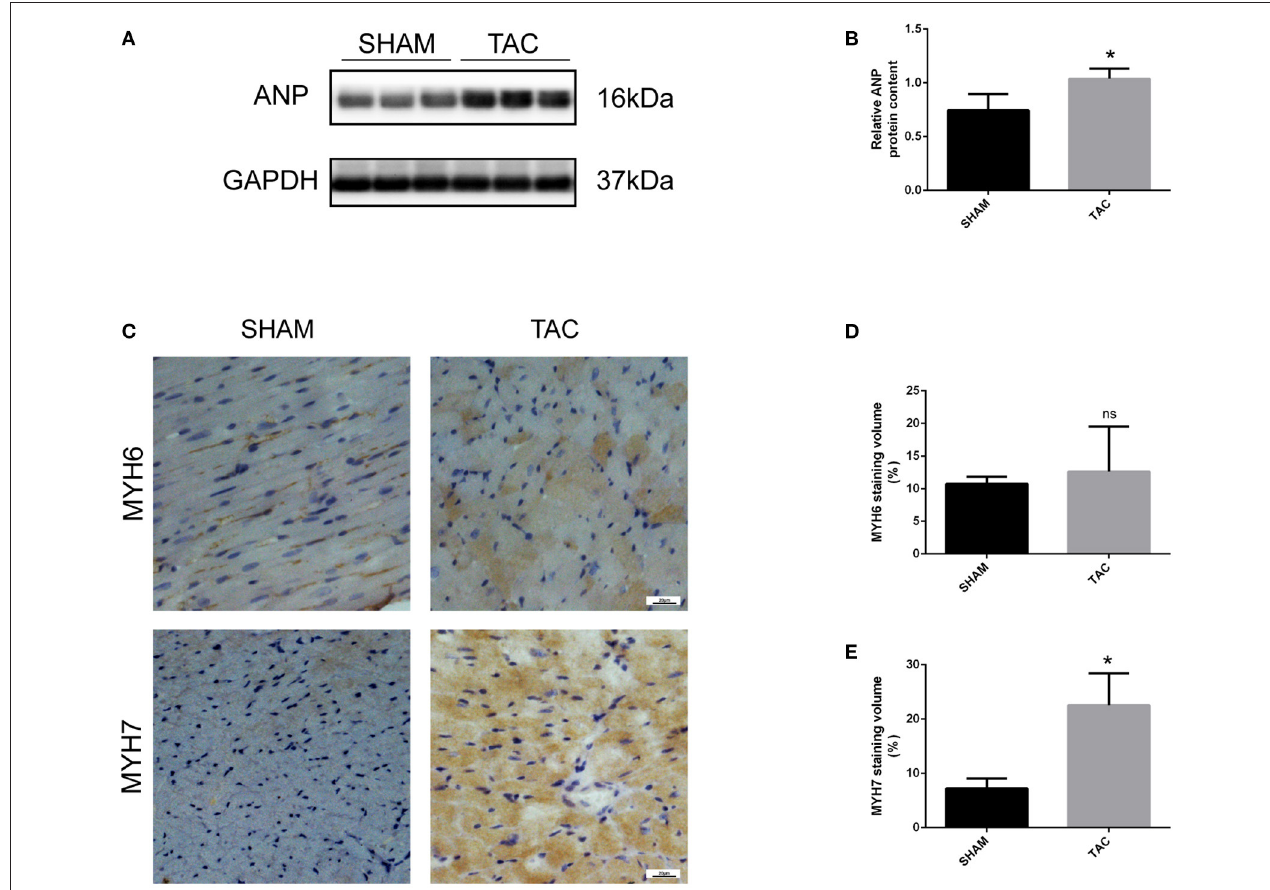
FIGURE 3 | Western blotting and immunohistochemical analysis of TAC mice. (A,B) Representative Western blot image and quantitative data of ANP in myocardial tissues. (C–E) Representative immunohistochemical staining images and quantitative data of MYH6 and MYH7 in myocardial tissues. * P < 0.05; ns, non-significant.